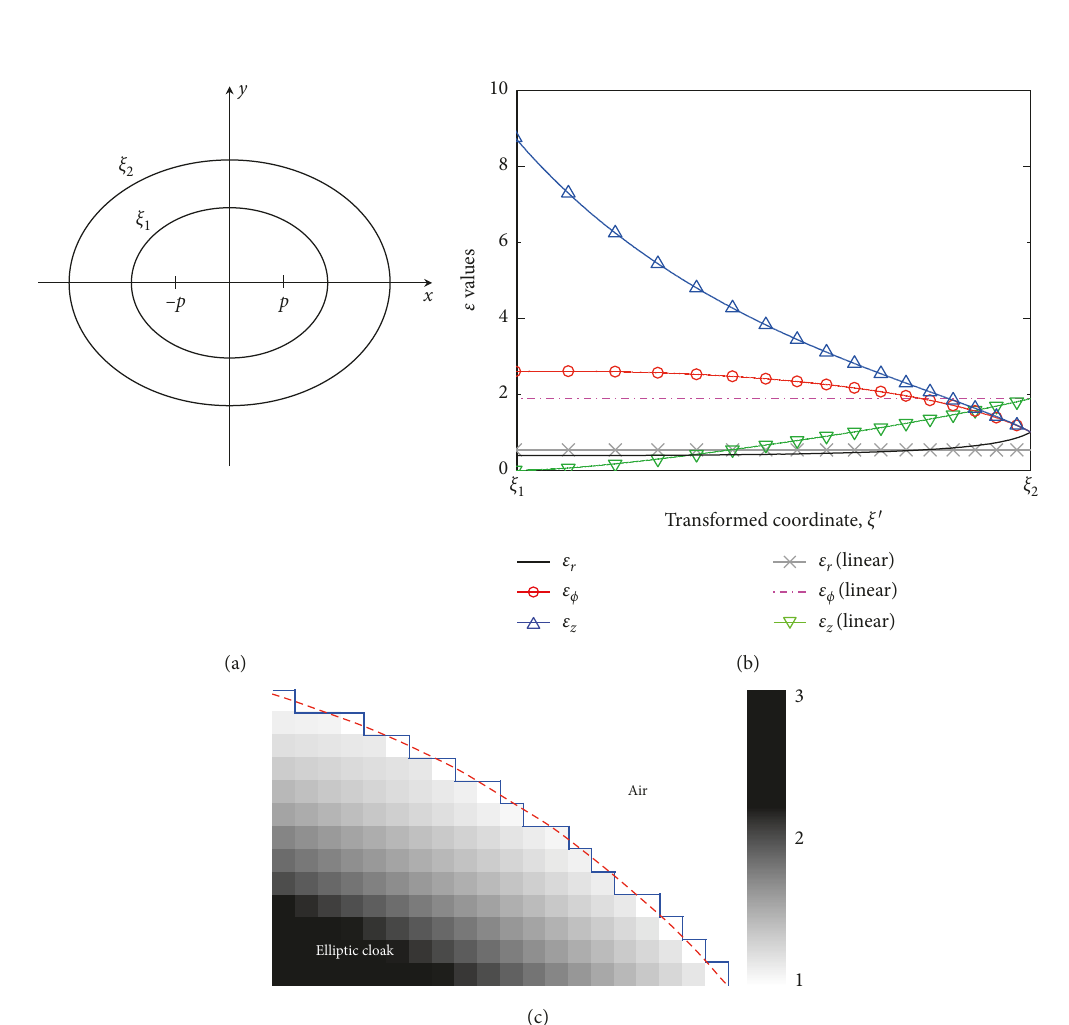
Figure 7: Application to an elliptic coordinate system: (a) the elliptic coordinate, (b) the material parameters obtained with (12), and (c) the μ z component obtained with (12) in a stair-cased